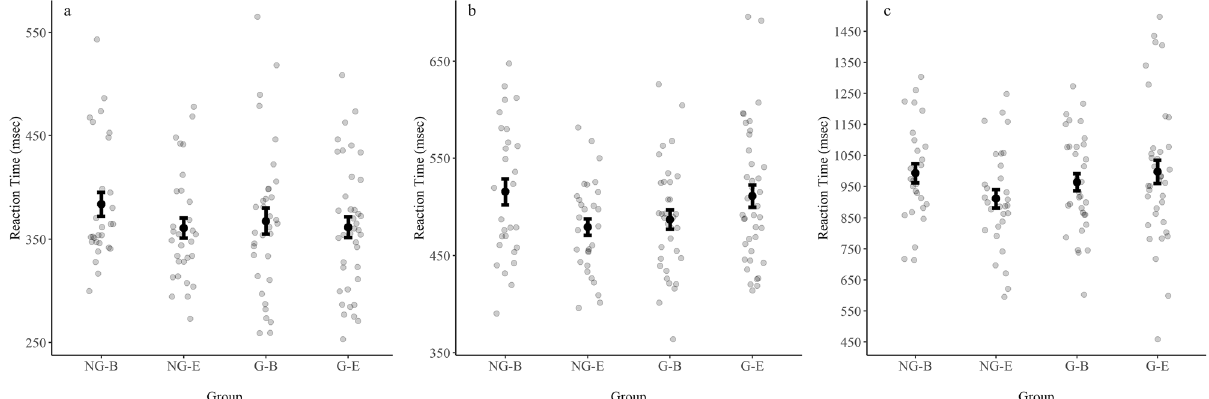
Figure 1. Mean RTs for the choice-RT task ( a ), the Simon task ( b ), and the alternate task-switching task ( c ), for the four experimental groups (figure created using R software). NG-B Non-gamers, questionnaire at the beginning, NG-E Non-gamers, questionnaire at the end, G-B Gamers, questionnaire at the beginning, G-E Gamers, questionnaire at the end. Note that the y-axis limits differ between graphs. Errors bars represent standard error. Small light-gray circles represent individual